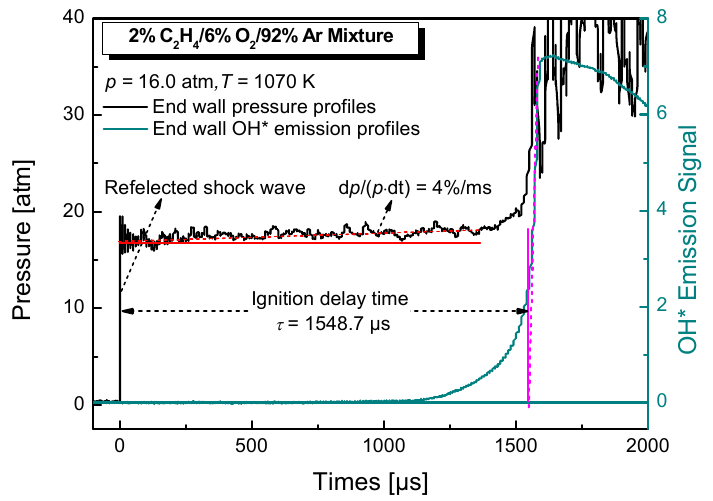
Figure 1. Typical end wall pressure and OH* time-history used to determine the ignition delay time.